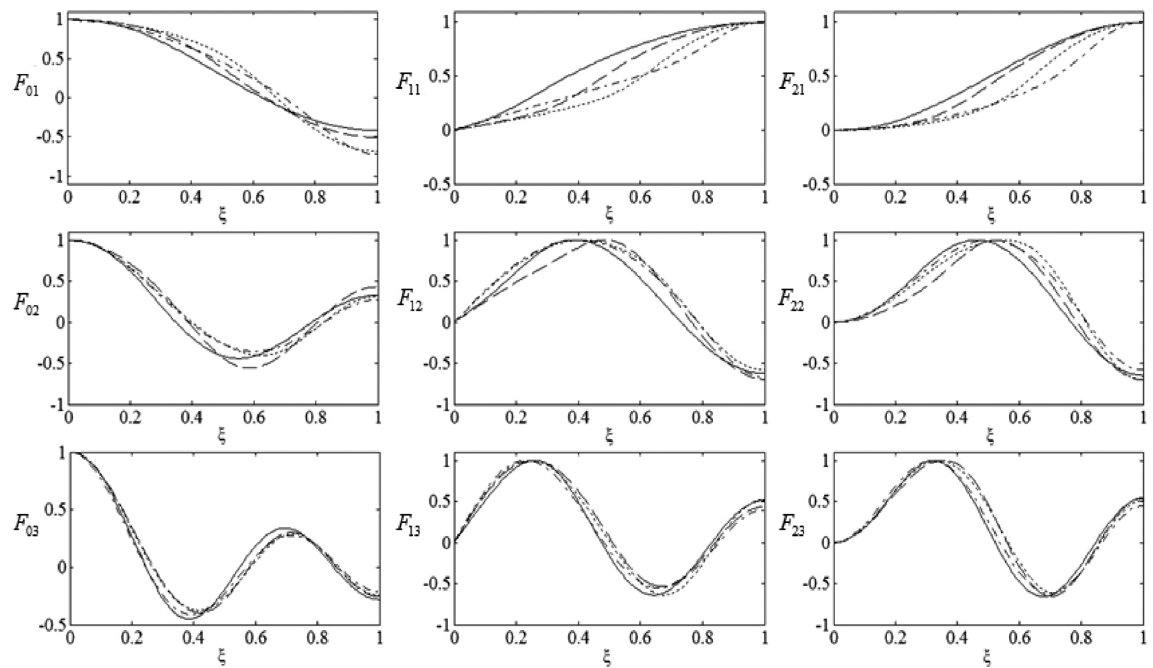
Fig. 5. Radial surface pro fi les F ml ( m = 0, 1, 2, l = 1, 2, 3) of the natural modes for β = 1, β 1 = 0.1 and four different α (—— α = 0.2, – – - α = 0.4, ······ α = 0.6, – · – α = 0.8).